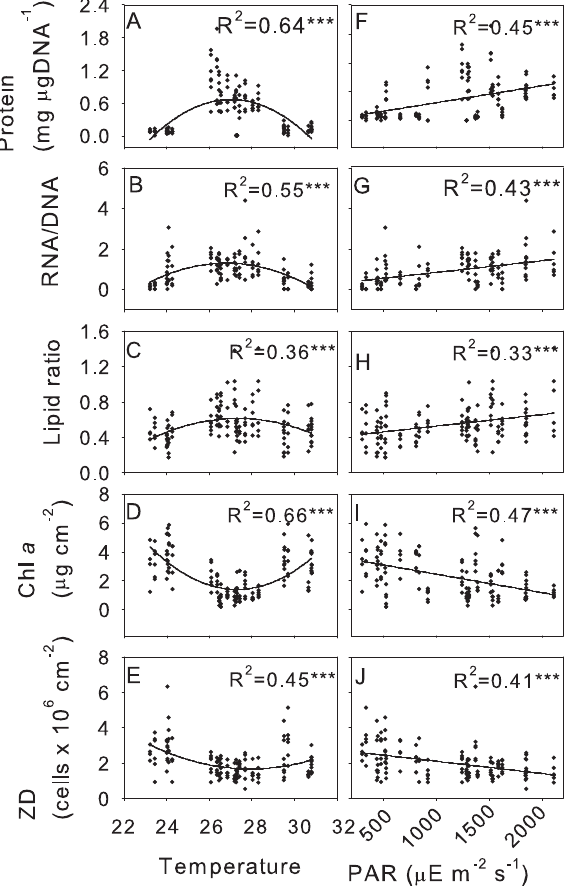
Figure 4. Correlation between health indices with temperature and light for Acropora digitifera. Quadratic correlations (R 2 ) of temperature (A–E) and linear correlations (R 2 ) of PAR (F–J) with Protein concentration, RNA/DNA ratio, lipid ratio, chl a concentration and zooxanthellae density.